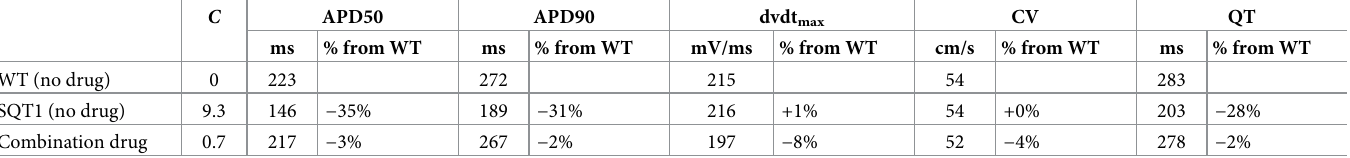
Cost function and biomarker values for the SQT1 human ventricular CM model based on an optimal combination of five drugs with the restriction D � min(EC 50 )/2 applied. The table follows the structure of Table 2.